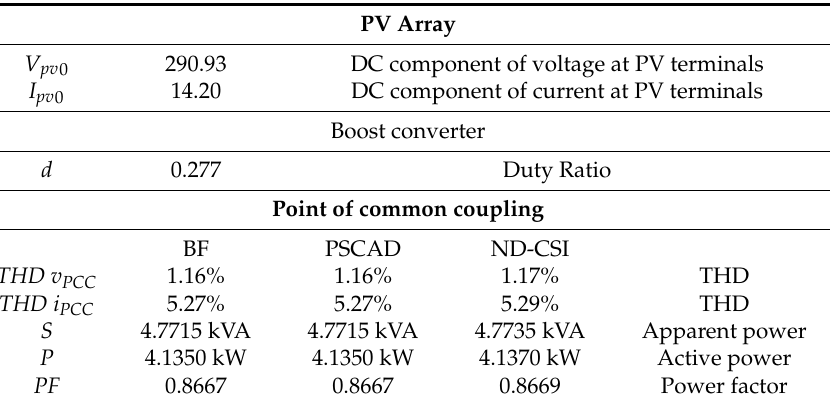
Table 3. Simulation results of test case.